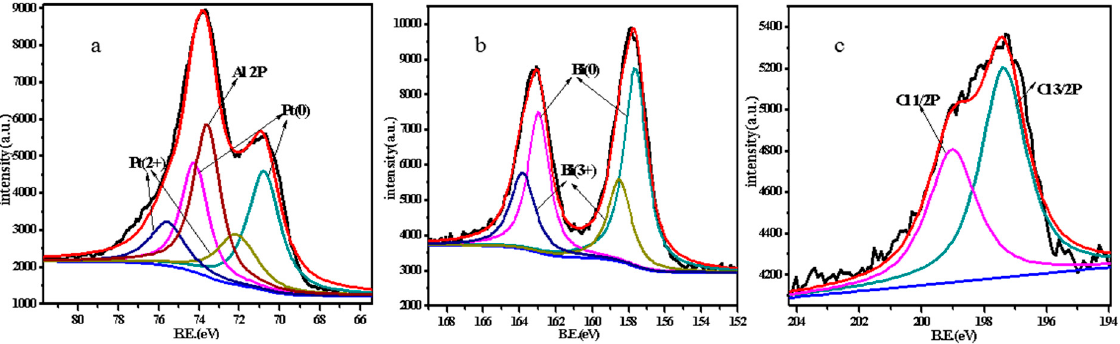
Figure 4. XPS spectra of Pt 4f ( a ), Bi 4f ( b ), and Cl 2P ( c ) in a typical Pt–7Bi/HT catalyst.